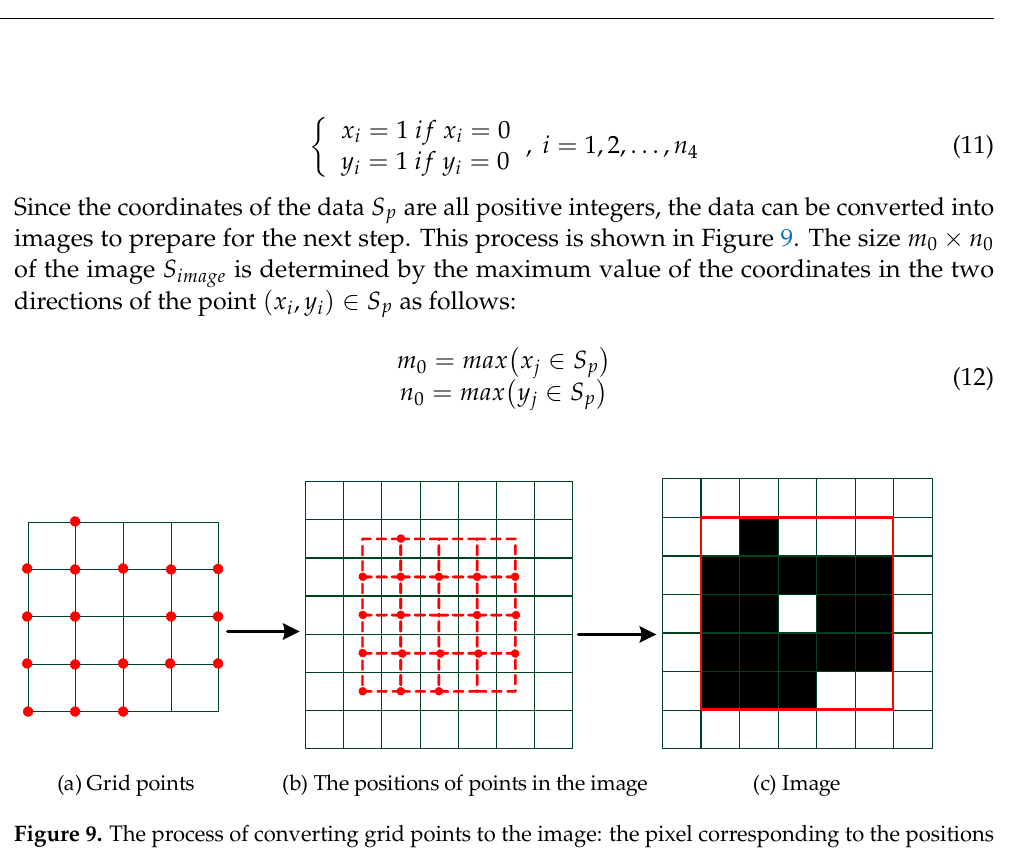
Figure 9. The process of converting grid points to the image: the pixel corresponding to the positions of the grid points in the image is given the value α . The image is made up of pixels in the red box in the final step. Table 2. Projection and transformation of data. First, the raw data are projected onto the ground plane. Then, the noise is removed by the GROR filter. We enlarge the coordinates 70 times and the grid subsampling method is used to make the data regular. The regular data can be converted to an image, which is prepared for the next section.